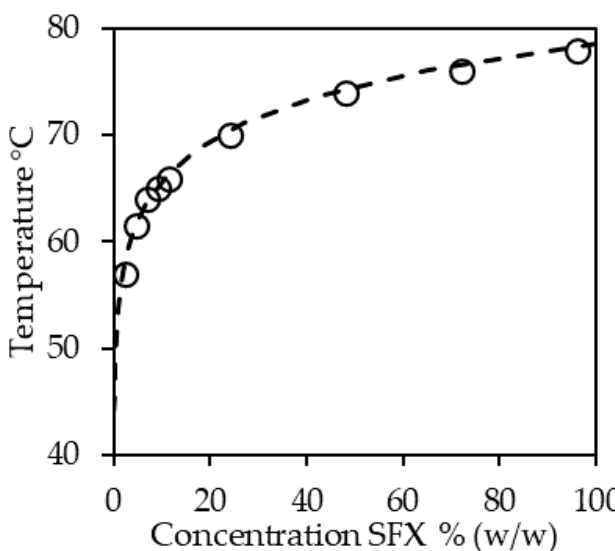
Figure 2. Dissolution temperature of sunflower wax ester (SFX) in canola oil. Temperatures deter- mined by differential scanning calorimetry (DSC). Temperatures exclusively assigned to waxesters present. Dashed dotted line calculated solubility curve for the waxester fraction in the sample assuming ideal solubility, adapted from [67].